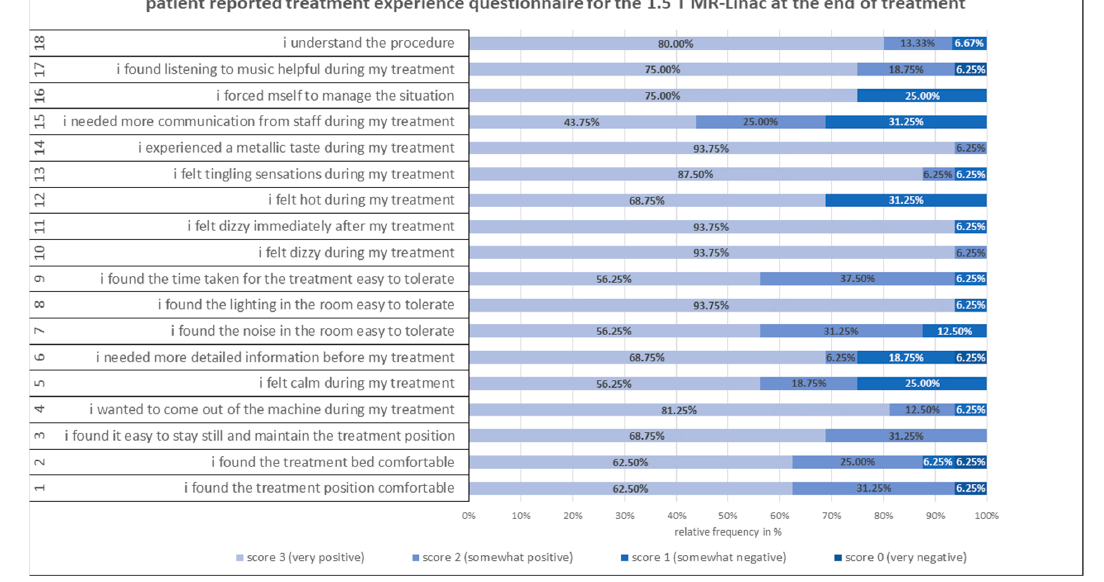
Figure 2. Validated patient-reported treatment questionnaire at the end of treatment using a Likert scale 1–4 for each of the 18 questions (left). Negative questions were post-processed for better comparability.